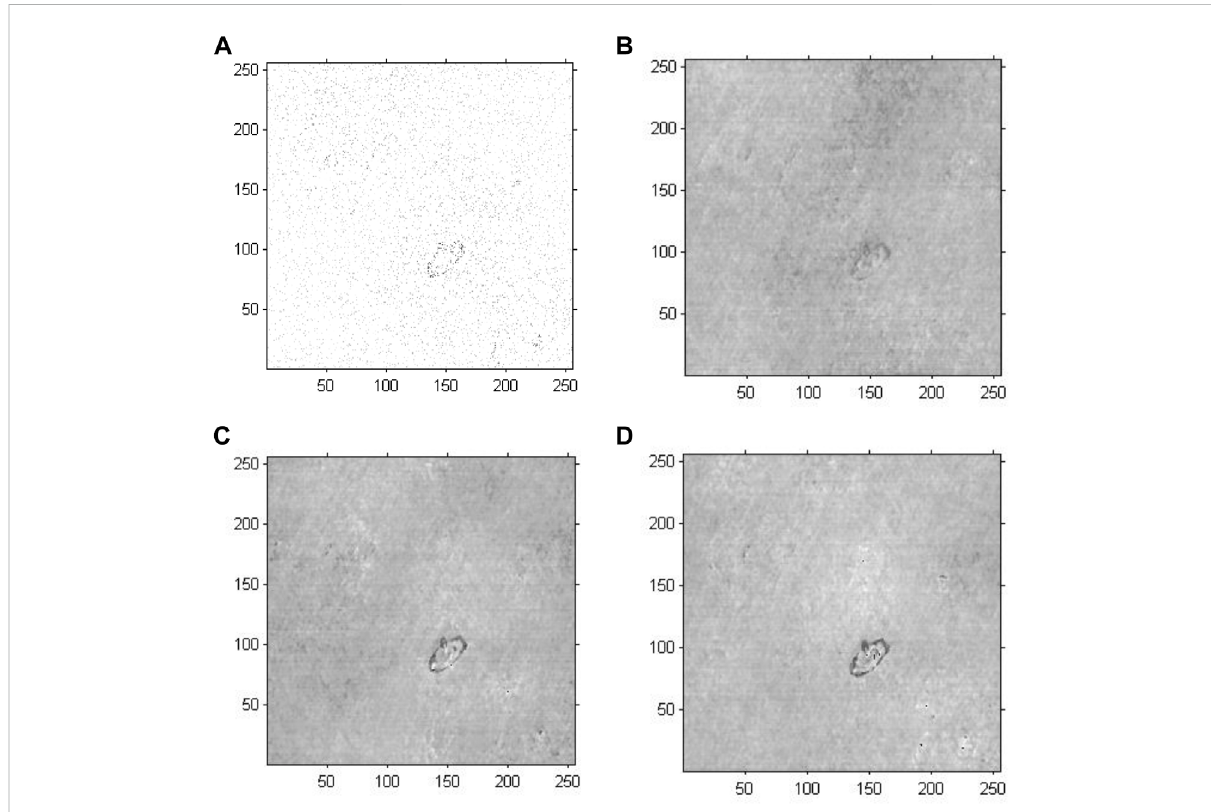
FIGURE 8 Phase reconstruction-based holographic image for Model 4 using the improved GS algorithm. (A) Optimized initial phase, (B) 20 iterative reconstruction images of phase information, (C) 200 iterative reconstruction images of phase information, and (D) 2000 iterative reconstruction images of phase